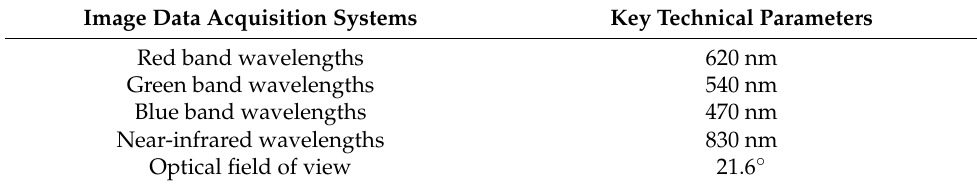
Table 5. Key technical parameters of image data acquisition